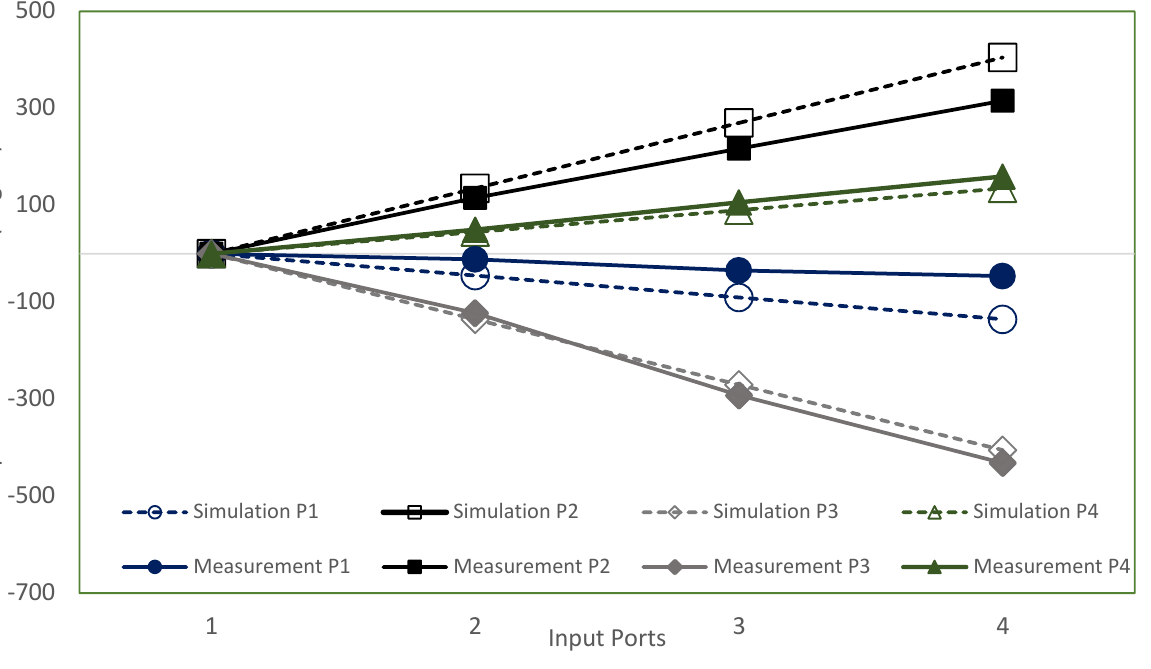
Figure 25. The transmission amplitude simulation and measurement. The simulation and measurement output phase difference results are shown in Figure 26. The output phase difference might be due to the extended strip line loss as discussed in the previous analysis (referring to Figure 6), where the phase delay is − 47 ◦ /mm resulting in φ ∆ L of − 30 ◦ for ∆ L = 30 mm. Although the phase delay is shifted with an average of 32 ◦ compared to the simulation, the trend of the output phase difference for each respective input can be seen to be progressive. The progressive phase difference at each respective output port is comparable to the theoretical value of ± 45 ◦ and ± 135 ◦ considering phase loss due to the extension line.